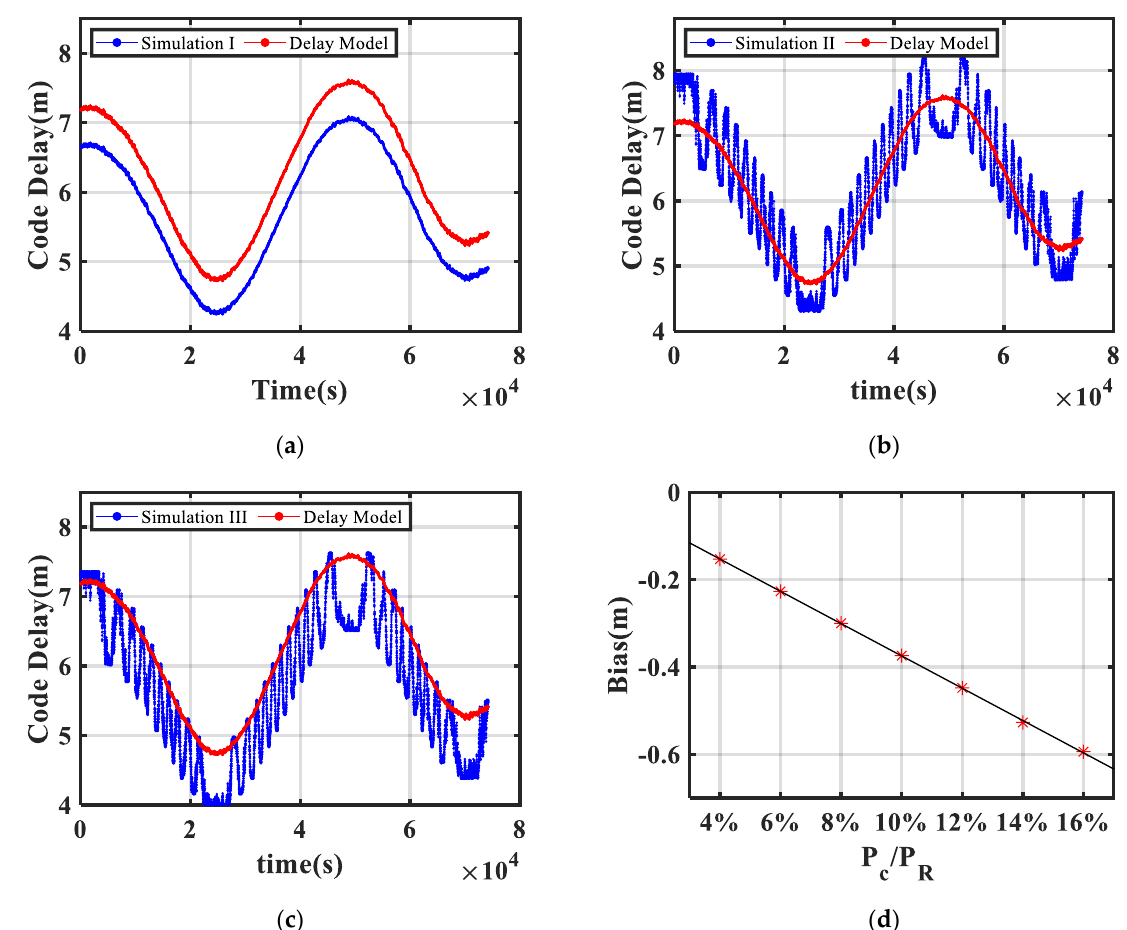
Figure 6. The simulation of the crosstalk impact on the code delay measurements: ( a ) The simulation I : 𝐴 𝑟2 + 𝐴 𝑐2 ;( b ) The simulation II : 𝐴 𝑟2 + 2 ∙ 𝐴 𝑐 ∙ 𝐴 𝑟 cos (𝛿𝜙) ; ( c ) The simulation III: 𝐴 𝑟2 + 𝐴 𝑐2 + 2 ∙ 𝐴 𝑐 ∙ 𝐴 𝑟 cos (𝛿𝜙) ; ( d ) The relation between the power ratio of the crosstalk signal and the reflected signal with the measurements bias.